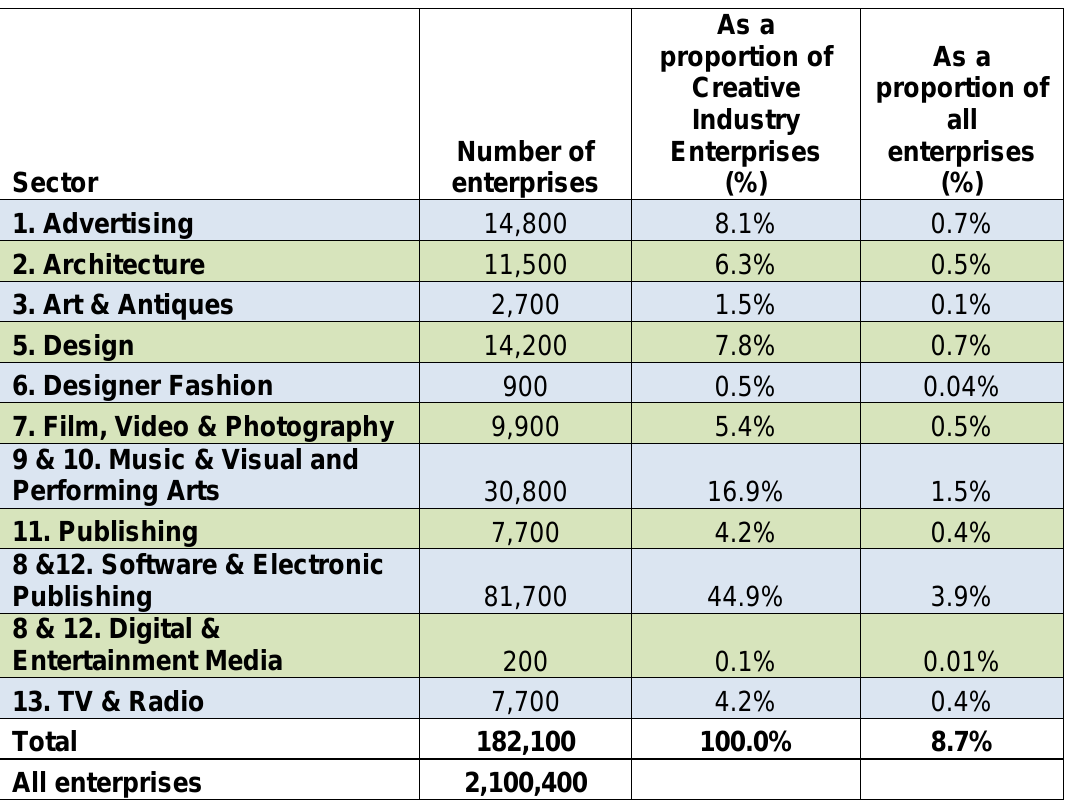
Table 3: Number of business in the Creative Industries, UK 2010